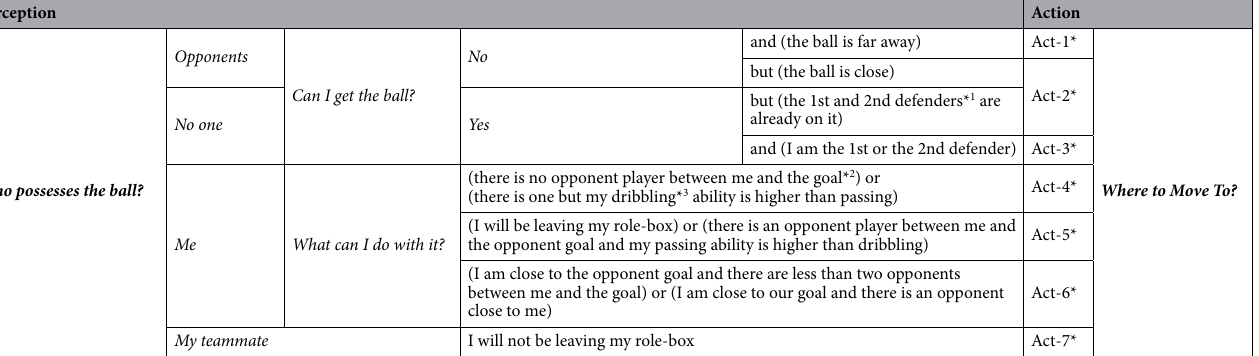
Table 1. The players’ perception of the environment and their respective actions. *Move randomly (Act-1), mark the nearest opponent (Act-2), get possession of the ball (Act-3), carry the ball (Act-4), pass the ball (Act-